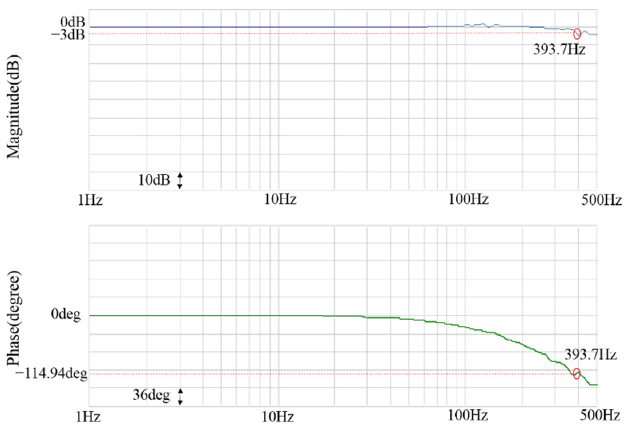
Figure 15. Bode plots of q -axis current control loop using PI-type SMC at 1000 rpm with 4.75 Nm.